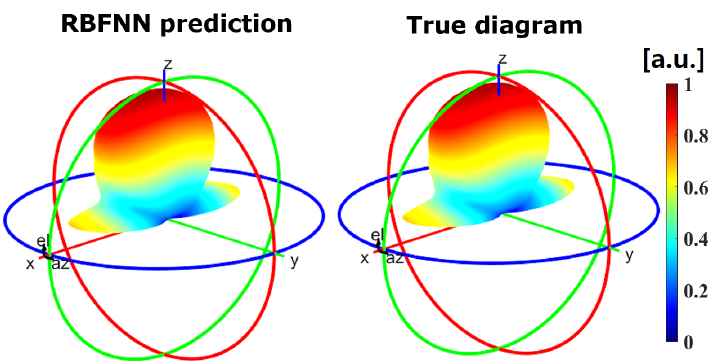
Figure 9. Comparison between the predicted normalized radiation pattern by the RBFNN of the non-tunable scenario ( left ) and the true diagram ( right ) for azimuth an elevation values of 89.5 and 88.7 degrees with respect to the normal direction,